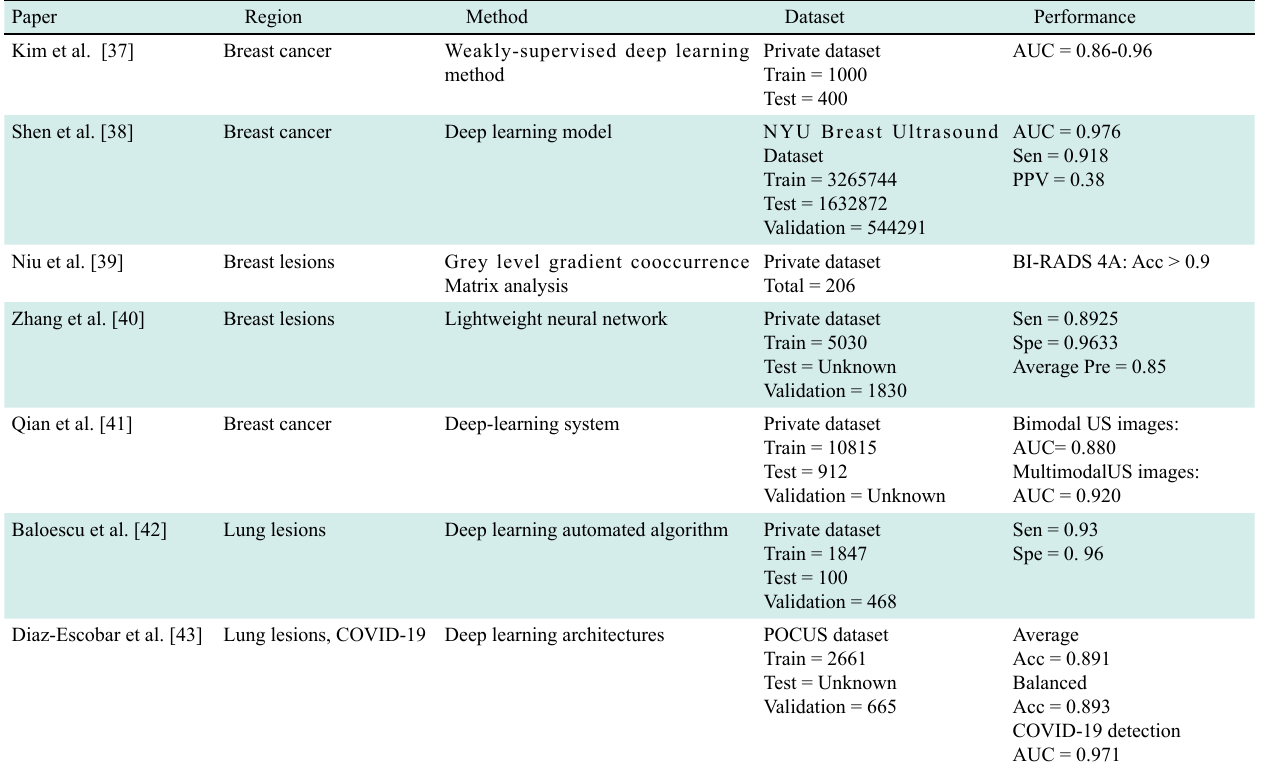
Table 3 Summary the region of interest, method, dataset, and performance of the major researches on AI in medical ultrasound detection in recent